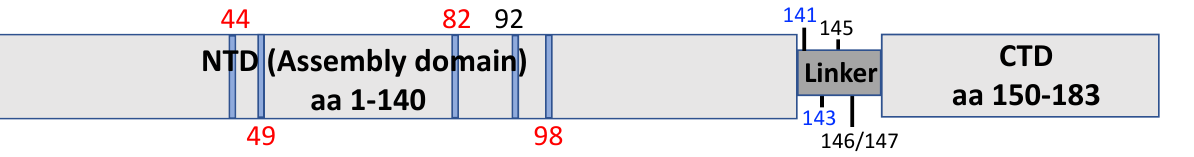
Figure 2. Schematic diagram of HBc domains highlighting residues important for viral entry. HBc residues, in the NTD and linker, shown to play a role in HBV entry are highlighted. Mutations at these positions can block cccDNA formation during HBV infection but allow/enhance cccDNA intracellular amplification. Mutations highlighted in red likely affect cccDNA formation via altered HBc phosphorylation state. Mutations marked in blue affect cccDNA formation via destabilization of nucleocapsids. Mutations listed in black affect cccDNA formation via an unknown mechanism, possibly through cytosolic transport or nuclear import. See text for details.